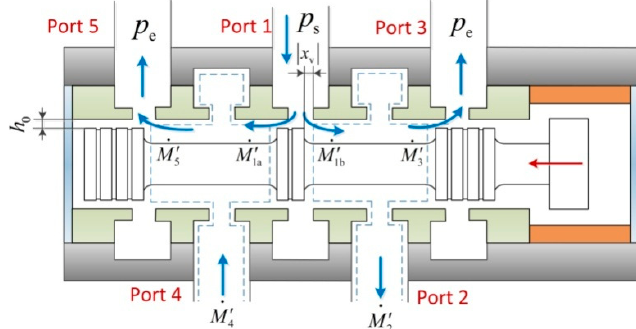
Figure 9. Gas flow mechanism when the spool moves backward.